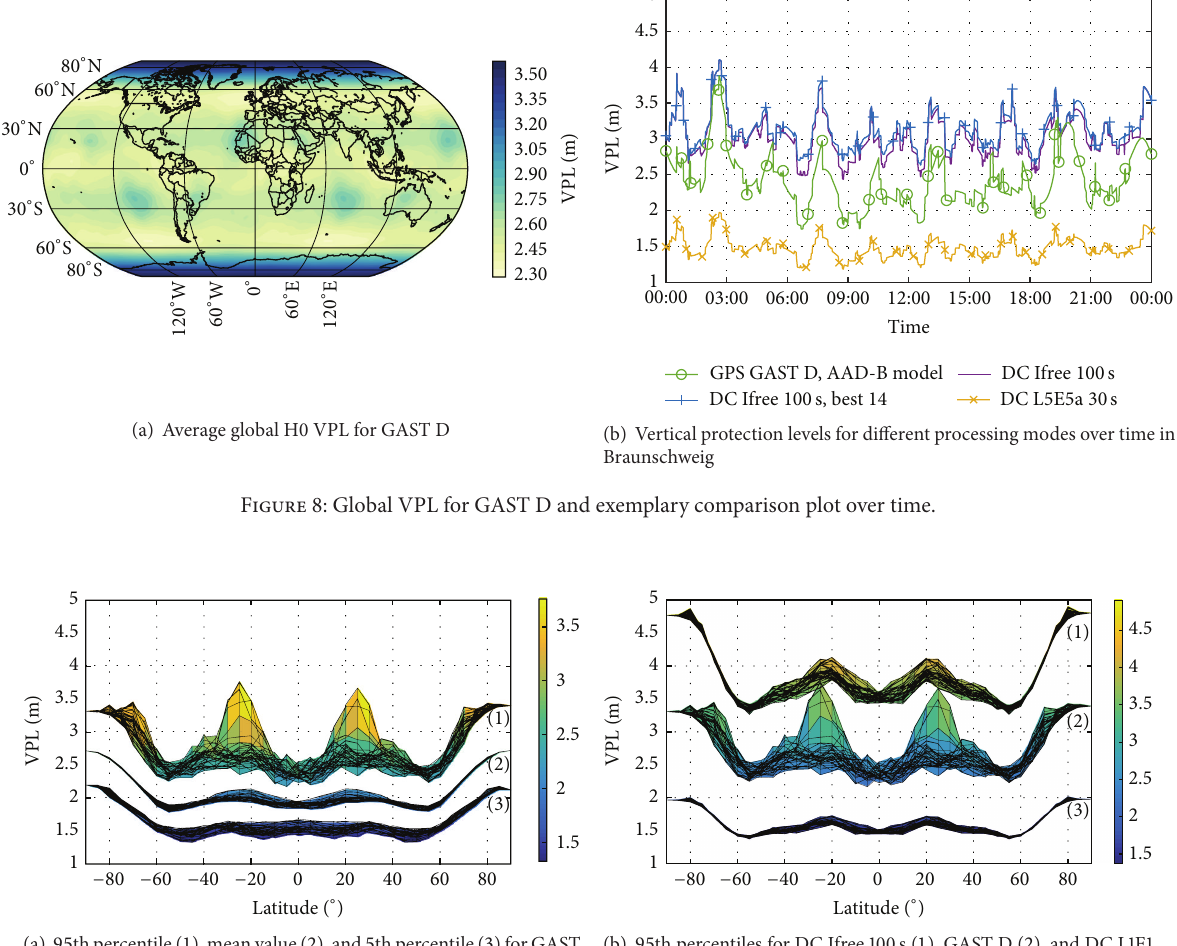
Figure 9: Global H0 VPLs stacked along longitudes. Vertical extents at each latitude represent the variation along longitudes.